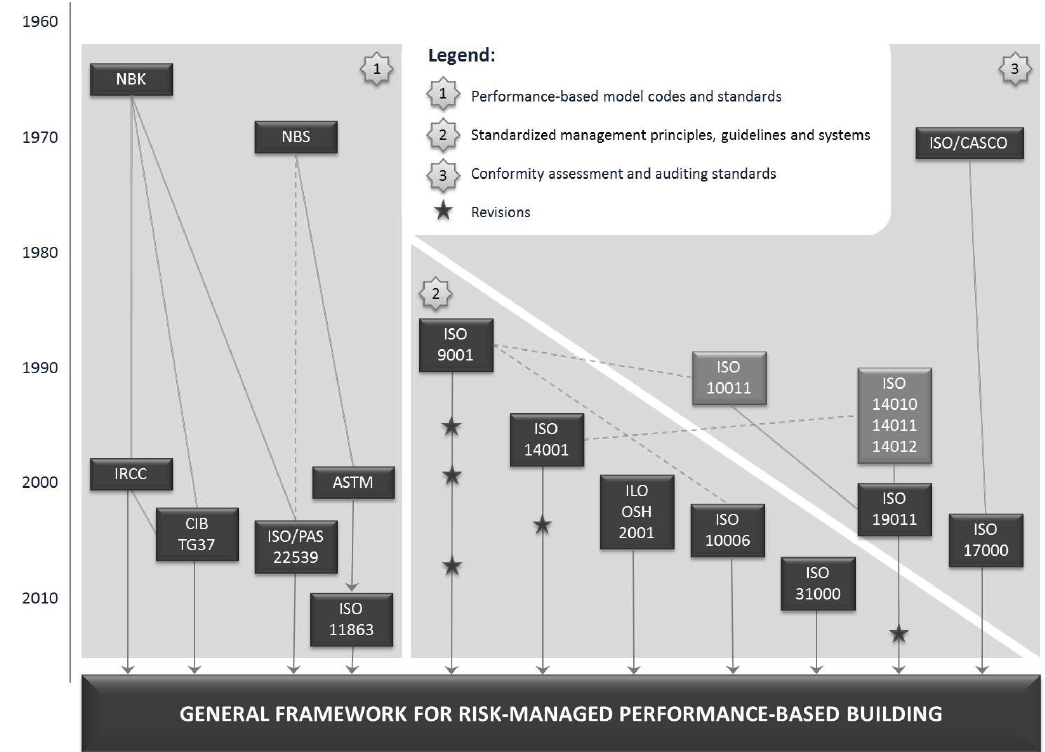
Fig. 1. Background of the final version of the proposed